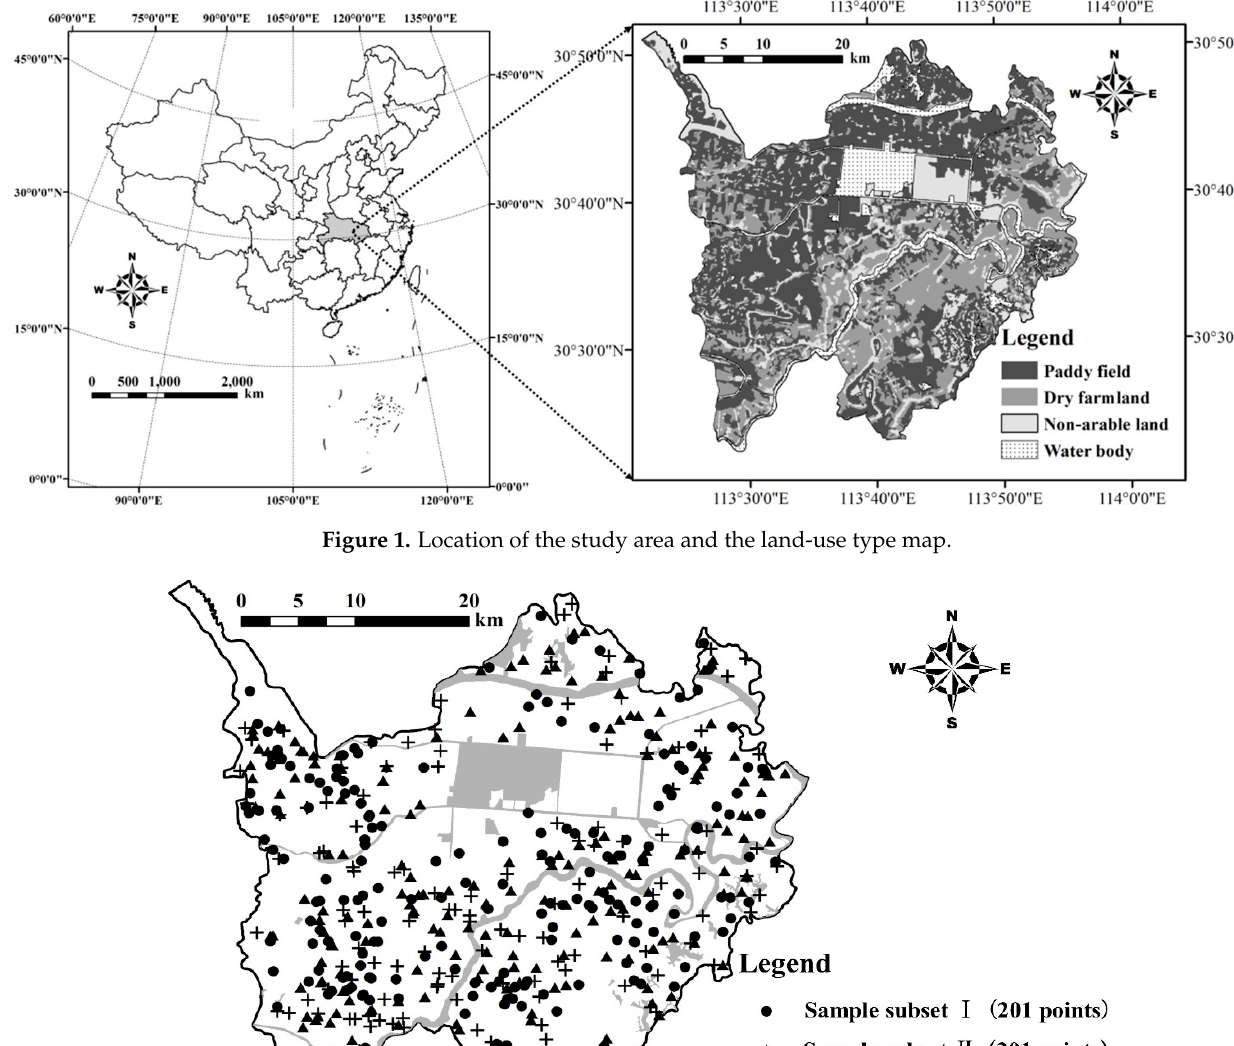
Figure 2. Spatial distribution of the sample subsets: validation subset (TN), sample subset I (TN and SOM), and sample subset II (SOM).